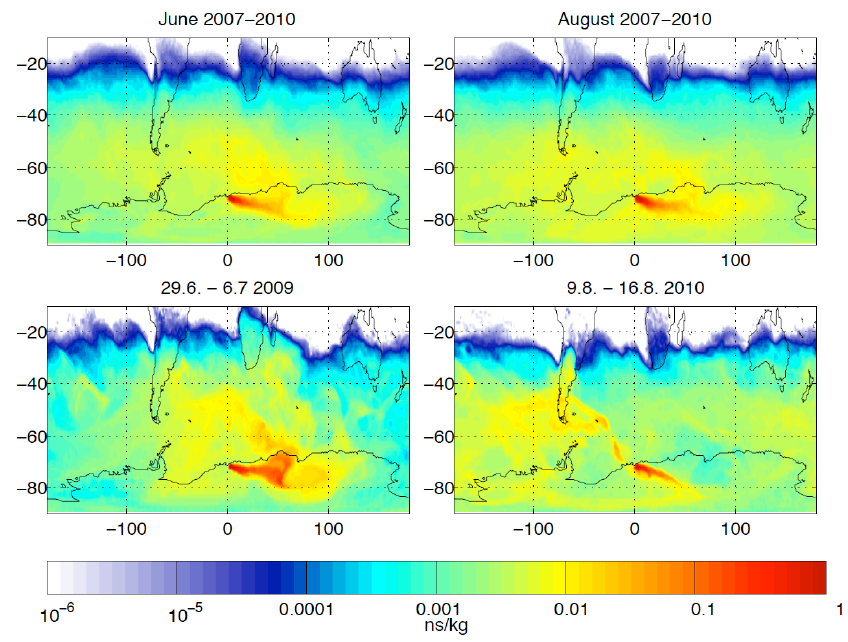
Figure 5: Footprint emission sensitivities calculated with FLEXPART. Upper line: Average monthly simulations (June and August) for the entire sampling period (2007–2010) as examples of the transport climatology for the respective months. Lower line: 20-day backward simulations for two weekly POP samples taken at Troll station during weeks 27/2009 (left) and 33/2010 (right).